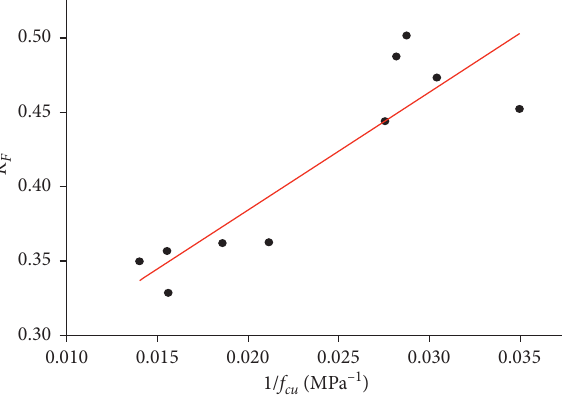
Figure 3: K T - α relationship.